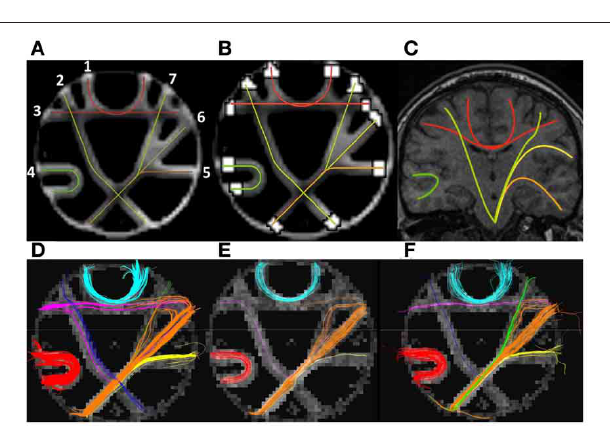
FIGURE 9 | (A) The ground truth fibers in the MICCAI 2009 Fiber Cup phantom dataset according to Côte et al. (2012). (B) Peripheral ROIs for tract definitions are shown as white areas. (C) Coronal brain slice indicating the fibers used as motivation for construction the phantom and its constituent fiber tracts. (D) Fibers extracted using our Spline method. (E) Fibers extracted using DTKTensor . (F) Fibers extracted using DTKODF . (A–C) are courtesy of Côte et al. (2012) and tractometer.org .